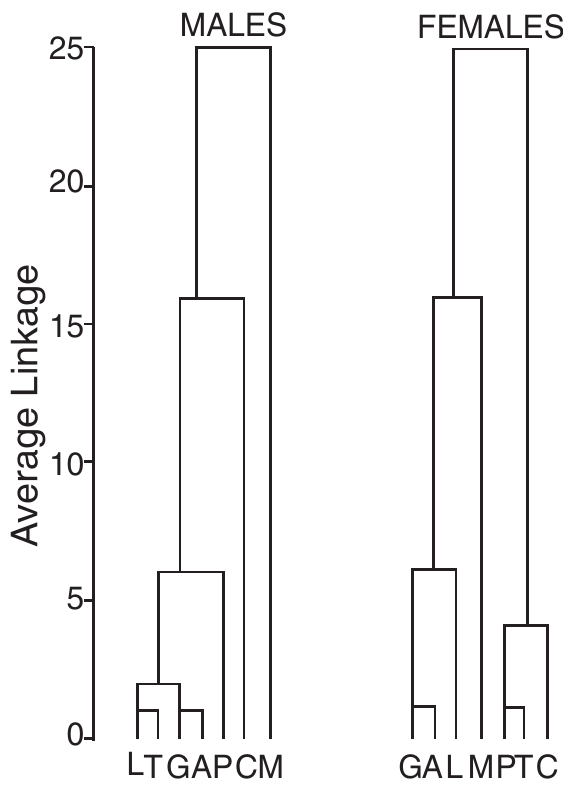
F IG . 5. – Cluster analysis using the Average Linkage method for the examination of the distances between the mean lengths-at-age of the 4 year old age group of the various areas for each sex sepa- rately. (P), Atlantic; (M), Alboran Sea; (C), Catalan Sea; (L), Ligurian; (T), Tyrrhenian; (A), Adriaric and (G): Euboikos